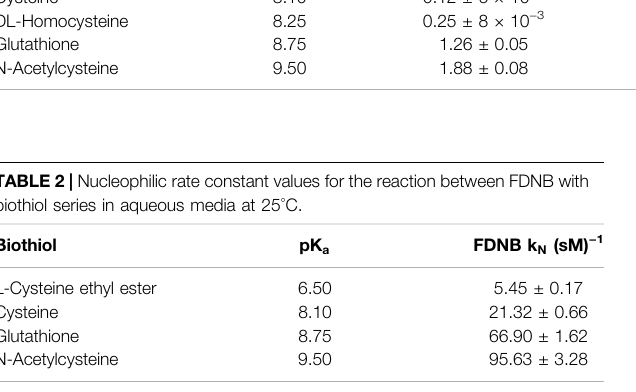
L-Cysteine ethyl ester